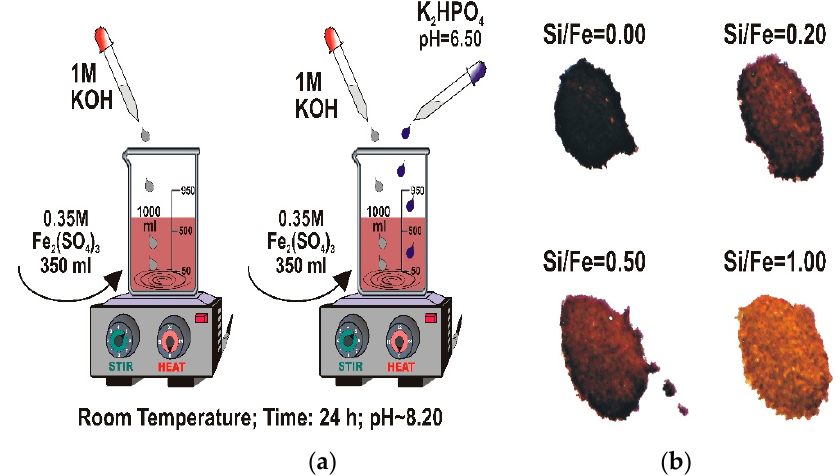
Figure 1. ( a ) Experimental setup for the synthesis of pure ferrihydrite and ( b ) photographs of ferrihydrite doped with P. The coprecipitation of P with ferrihydrite results in the brightening of the dry product.